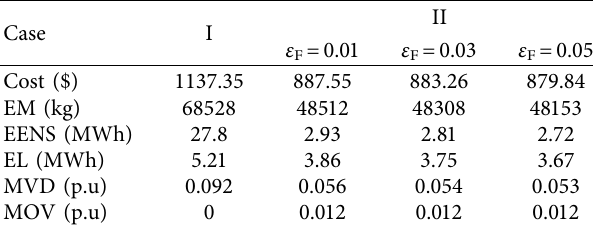
Table 5: Technical and economic